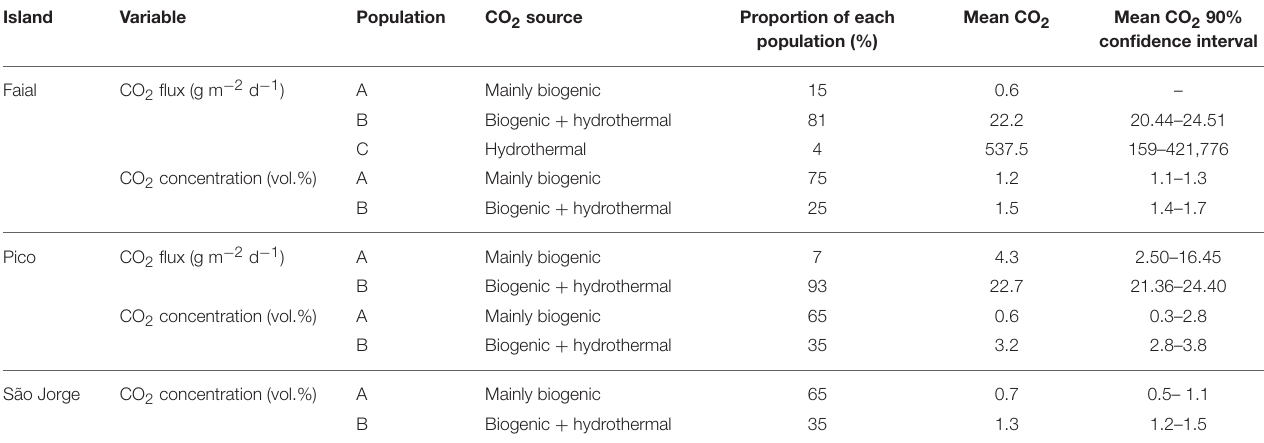
TABLE 4 | Statistical parameters from the partitioned CO 2 concentration/flux populations and the 90% confidence intervals of the mean.